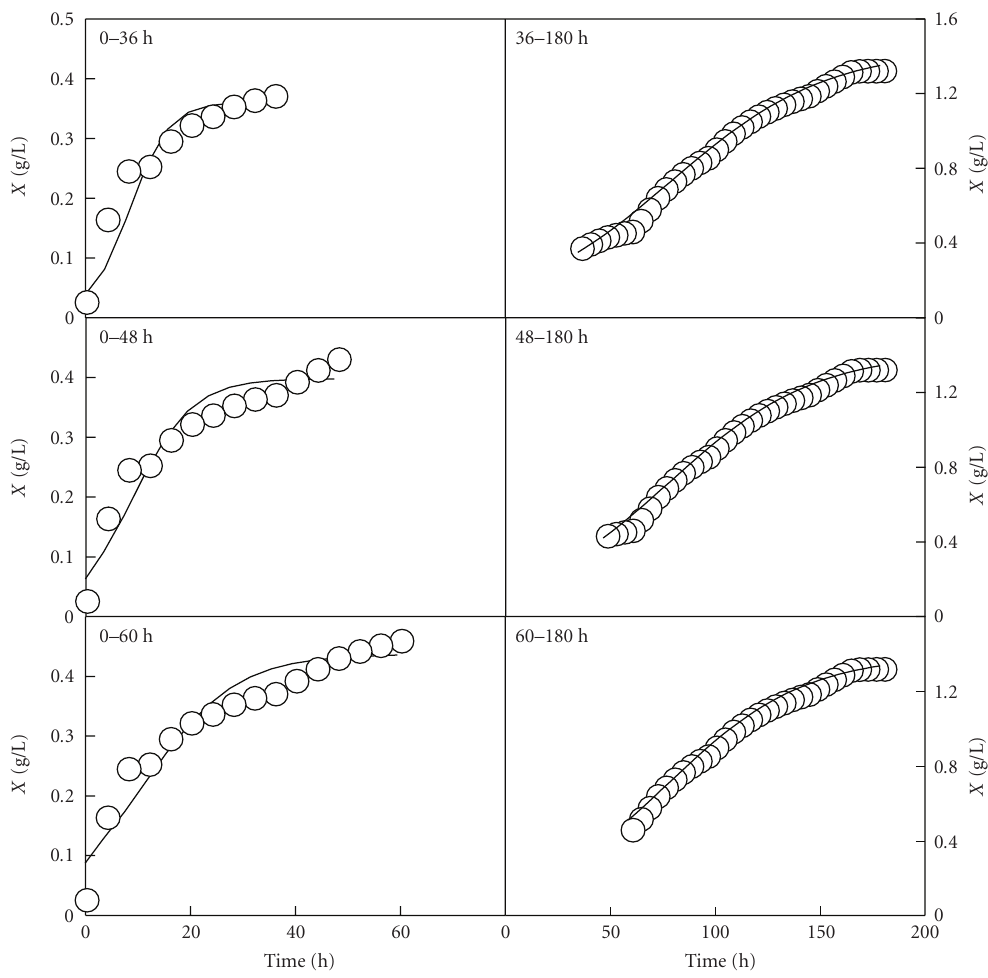
Figure 5: Growth curves of Ent. faecium CECT 410 corresponding to the first (left part) and second (right part) growth phases observed in the realkalized fed-batch fermentation I. The growth data (symbols) represented in the left and right parts are the biomass data showed in Figure 3. The solid lines drawn through the experimental biomass data (left and right part) were obtained according to the Logistic models (A.1) and (A.2),